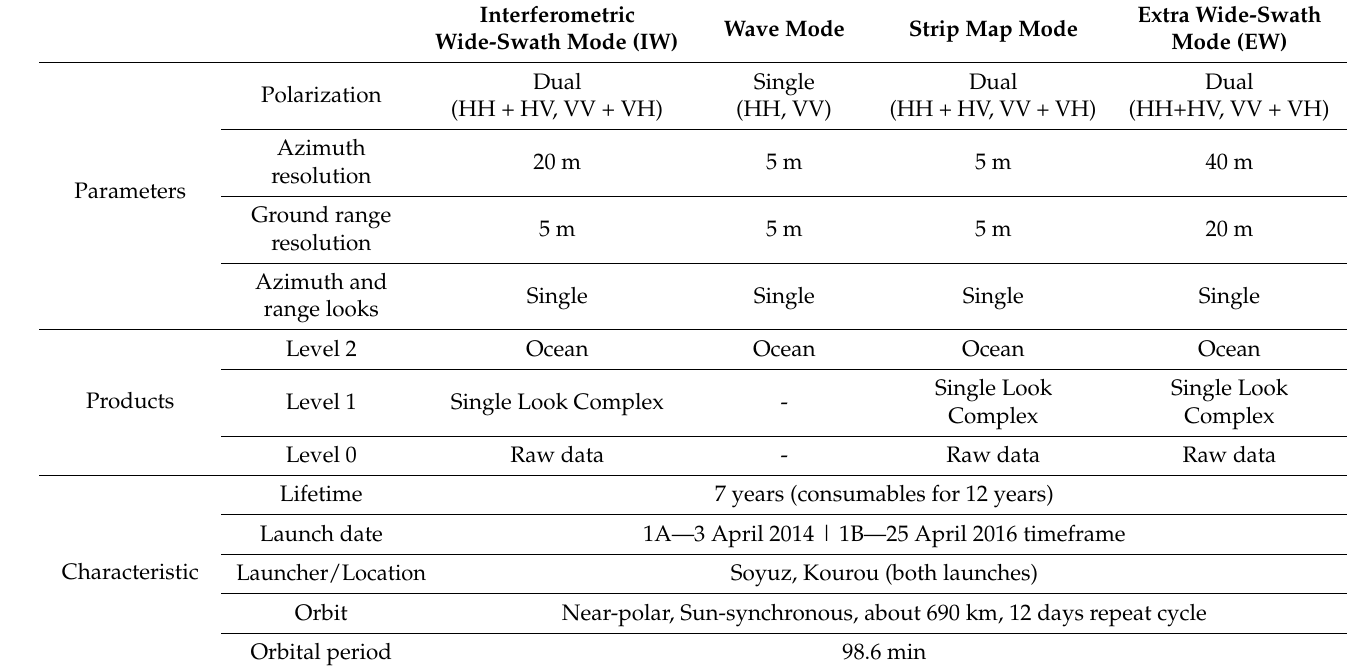
Table 1. Sentinel-1 satellite characteristics